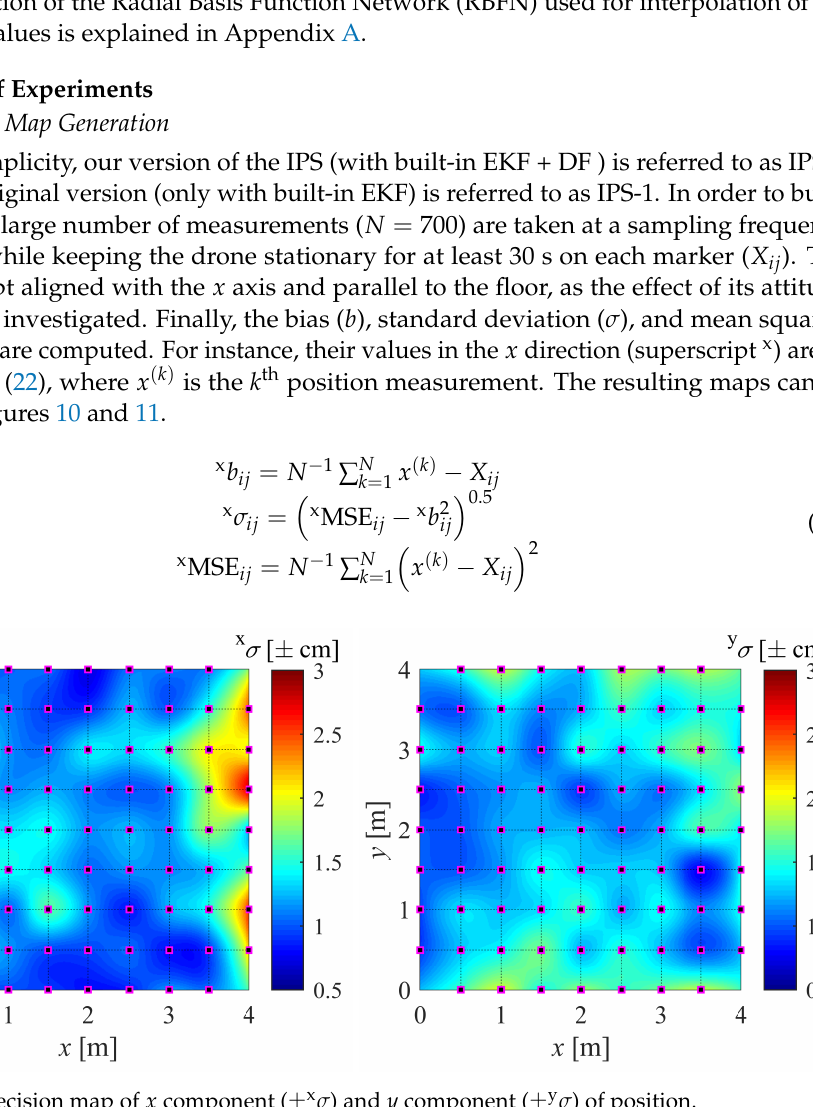
Figure 10. Precision map of x component ( ± x σ ) and y component ( ± y σ ) of position.